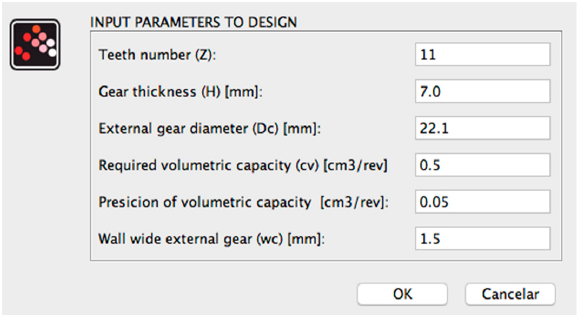
Figure 2. Design module basic parameters in GeroLAB Package System [29].